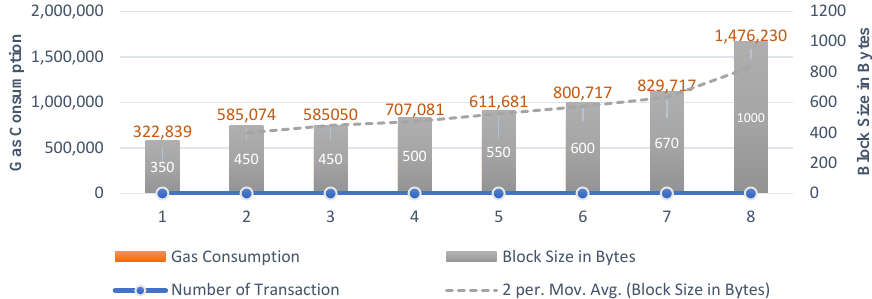
Figure 6. Depending on block size and transaction volume, gas is used.